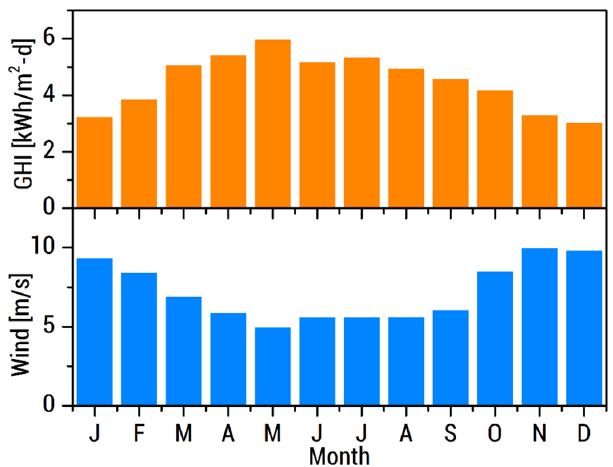
Figure A1. Renewable energy data in Sabtang Island—GHI ( top ) and wind speed ( bottom ).